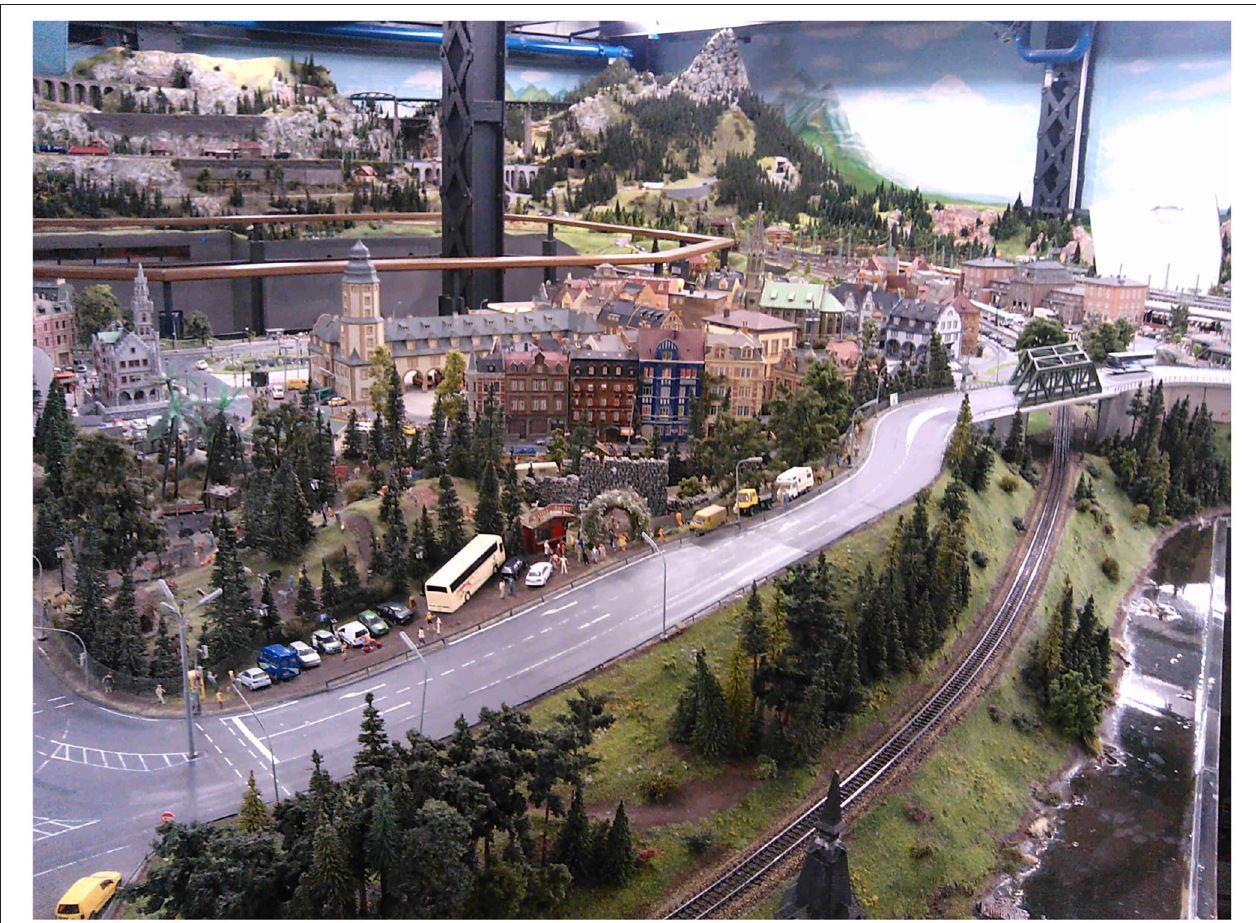
FIGURE 2 | Sample view on the Miniatur Wunderland model railroad on a scale of 1:87. Parts of the 1,545 m 2 layout are used for tests (Tiedemann, 2019; Wunderland, 2021, under CC-BY